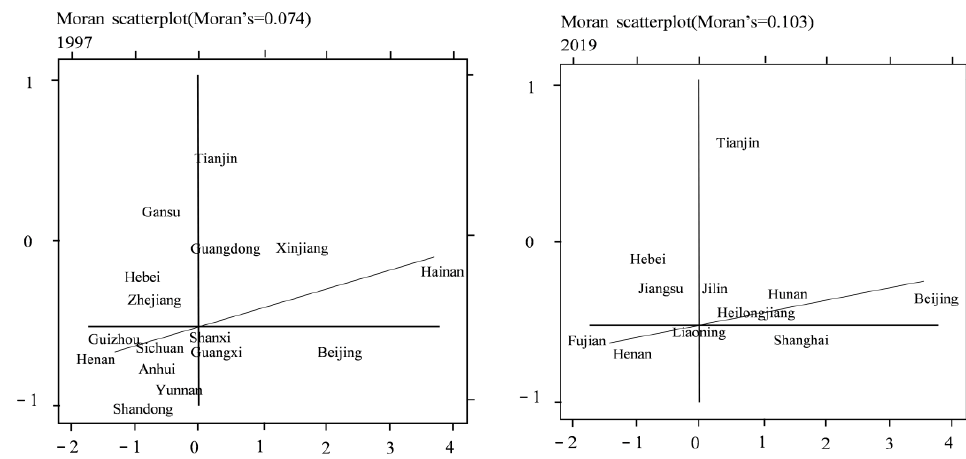
Figure 5. Local Morantu of 1997 and 2019 industrial structure upgrading index.